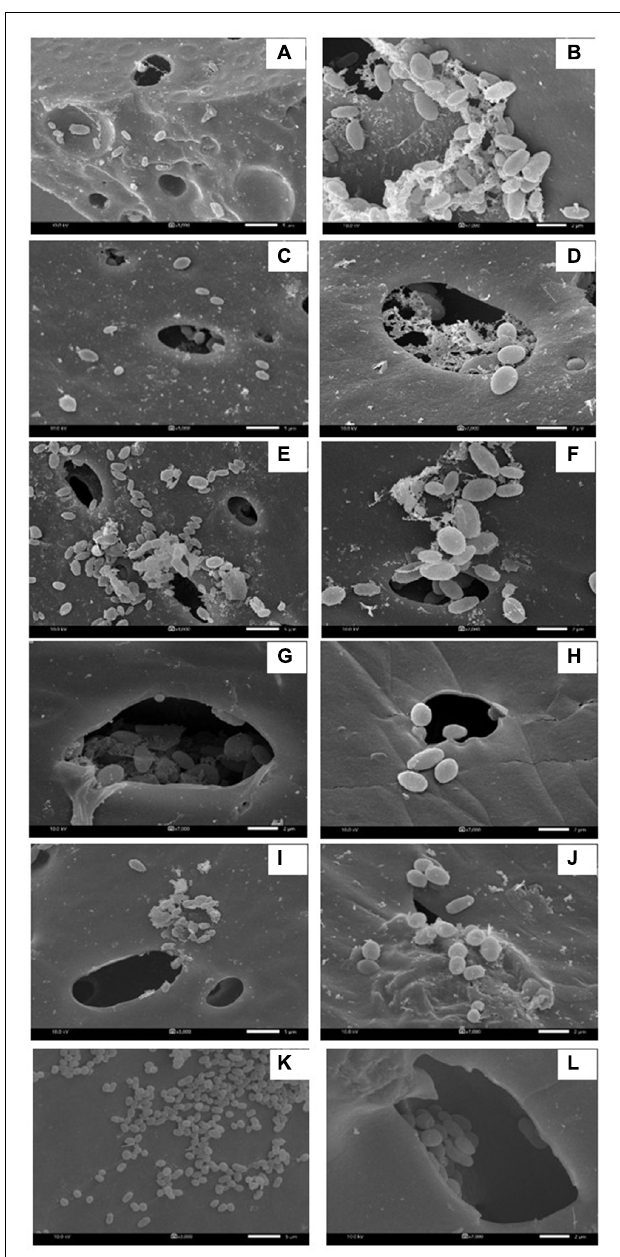
FIGURE 5 | Characteristic of immobilized cells after washing and reactivation processes. There were washed immobilized cells from the 1st production cycle (A,B) , 3rd production cycle (C,D) , 4th production cycle after cell reactivation (E,F) , 6th production cycle (G,H) , 7th production cycle after cell activation (I,J) and 9th production cycle (K,L) . The 3000X magnified image is shown on the left while the 7000X magnified image is displayed on the right.